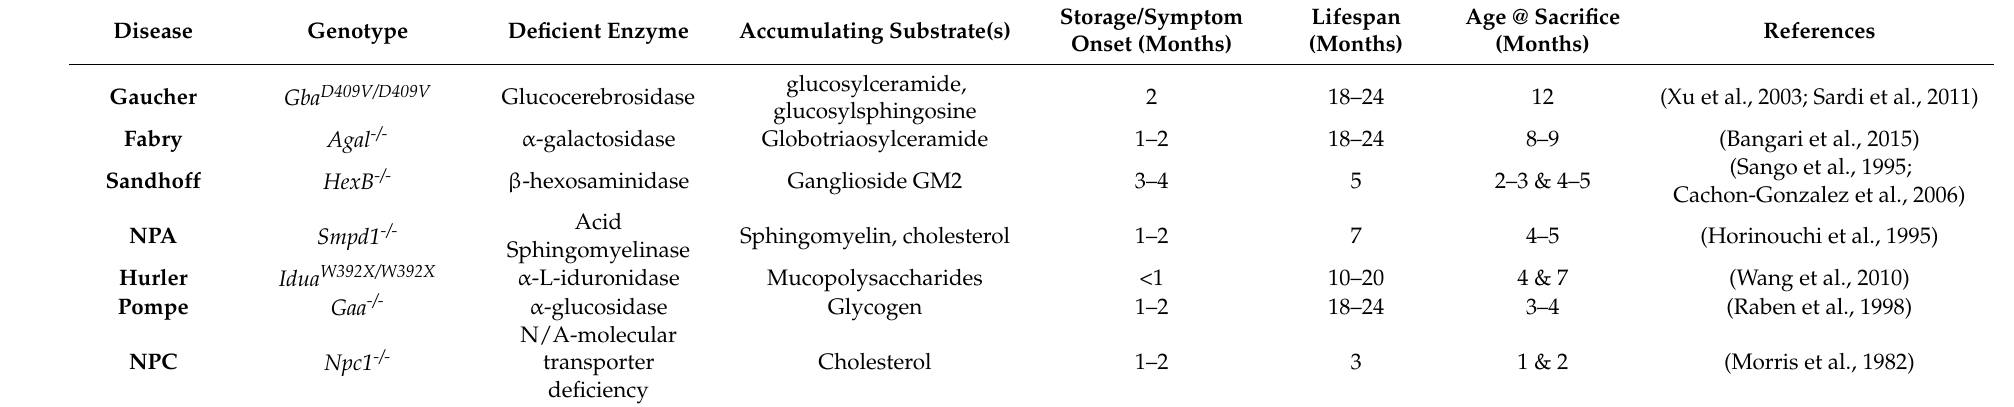
Table 1. Mouse models of metabolic